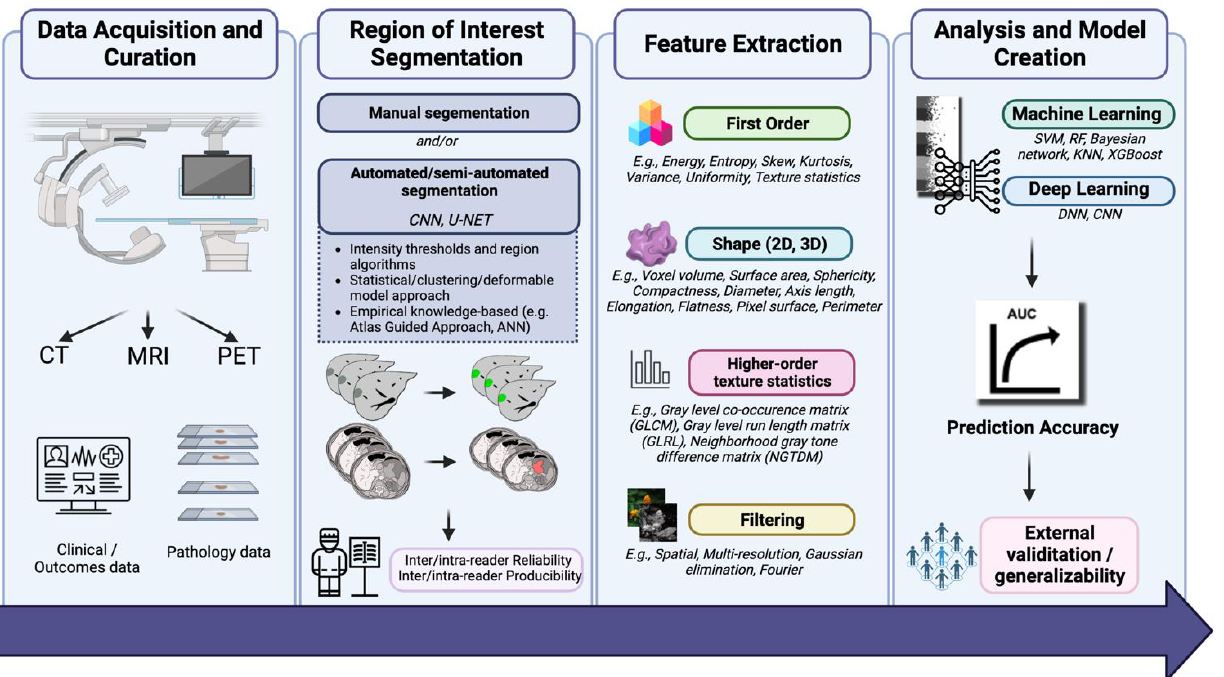
Figure 1. Flowchart of application of AI in radiology for GI cancers.